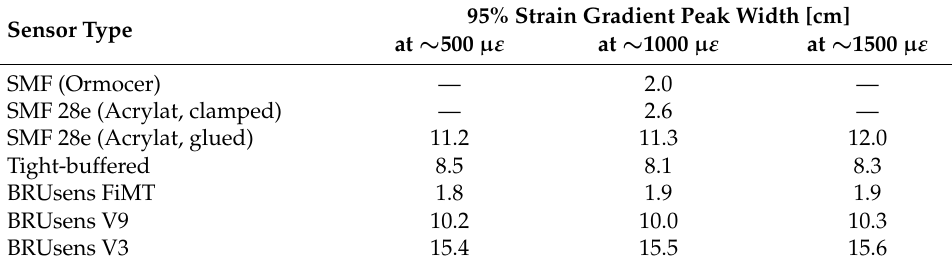
Table 2. Derived spatial resolution impact lengths for different sensors and load levels.